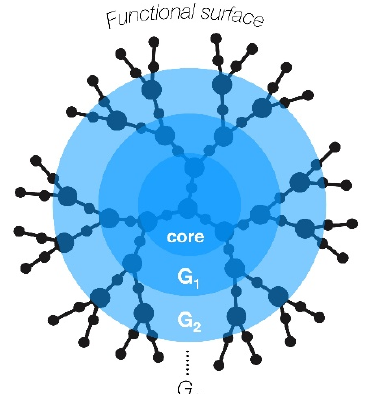
Figure 1. Schematic representation of a dendrimer nanoparticle, showing the core, repetitive branching units (dendrons) that constitute the growing layers (generations, G) and terminal groups (functional surface).